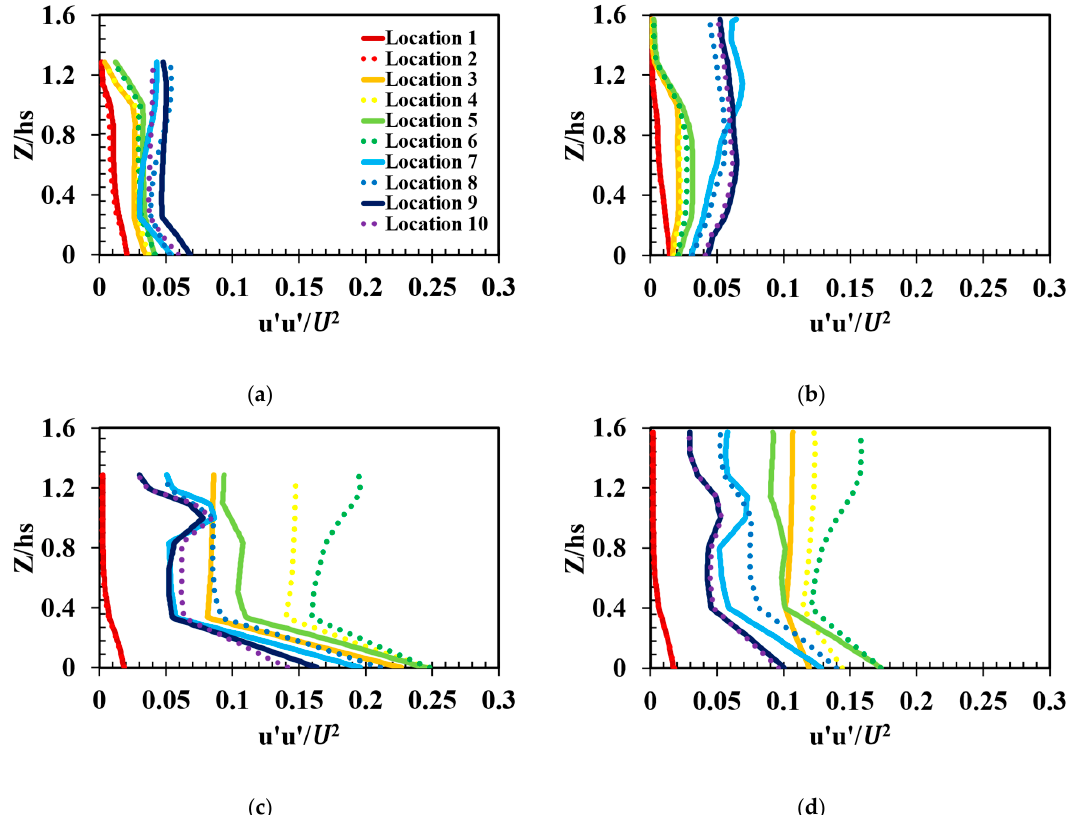
Figure 8. ( a – d ) The vertical profiles of normal stresses ( u’u’ ) at specified locations: ( a ) case 1; ( b ) case 2; ( c ) case 3; ( d ) case 4.